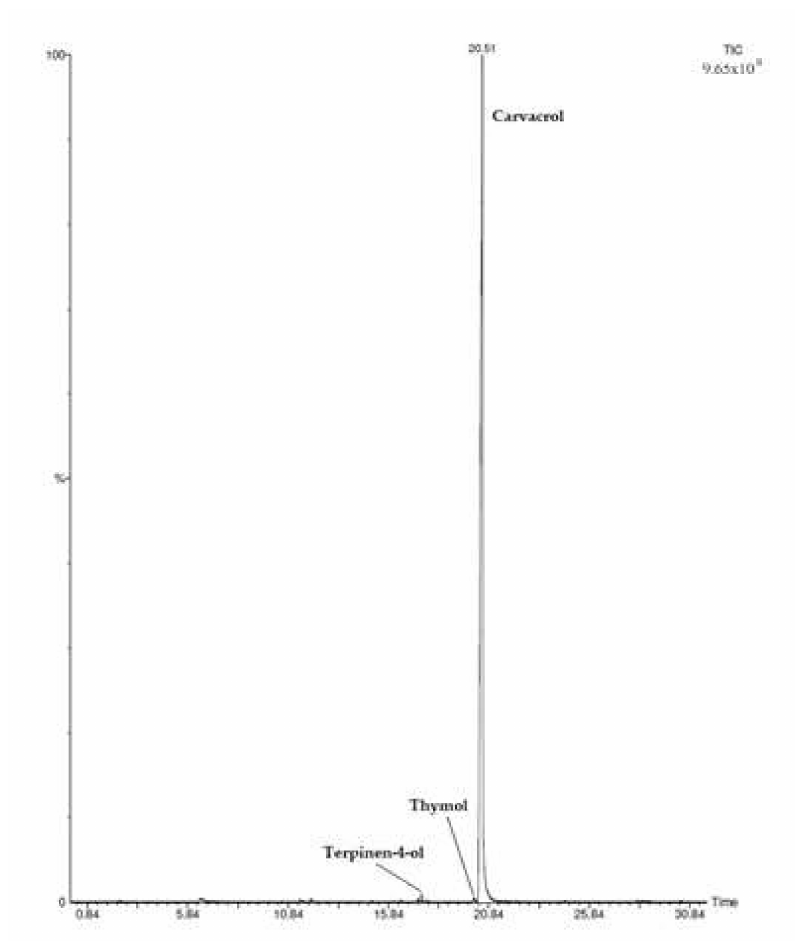
Figure 1. HS/GC-FID Chromatogram of Coridothymus capitatus Hydrolate. Table 1. Chemical composition (percentage mean value ± standard deviation) of CHY. The table displays: the components reported according to their elution order on apolar column, Molecular weight (MW); Molecular Formula (MF), the Linear Retention Indices measured on apolar column (LRI m ); the Linear Retention Indices from literature (LRI t ); mass-to-charge ratio ( m / z ); percentage mean values of Coridothymus capitatus vapor phase components ( C. c. ) (peak area